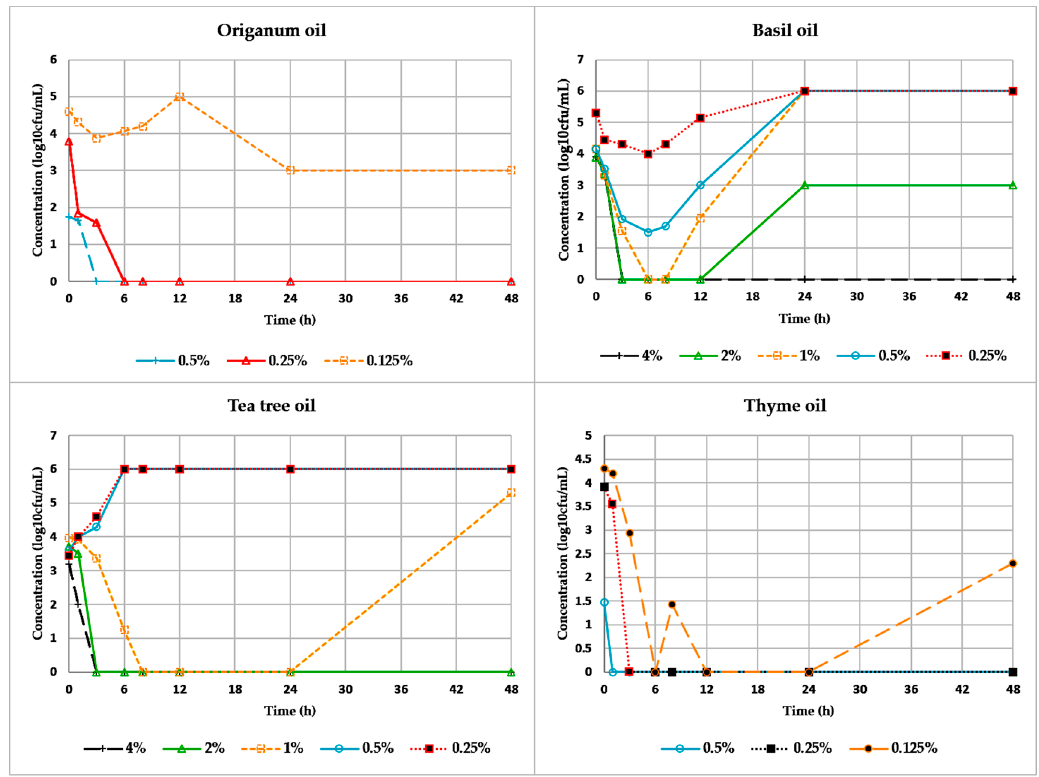
Figure 3. Time-kill kinetics for origanum oil, basil oil, tea tree oil, and thyme oil on the MRSA no. 4 clinical isolate (isolated from wound swab).